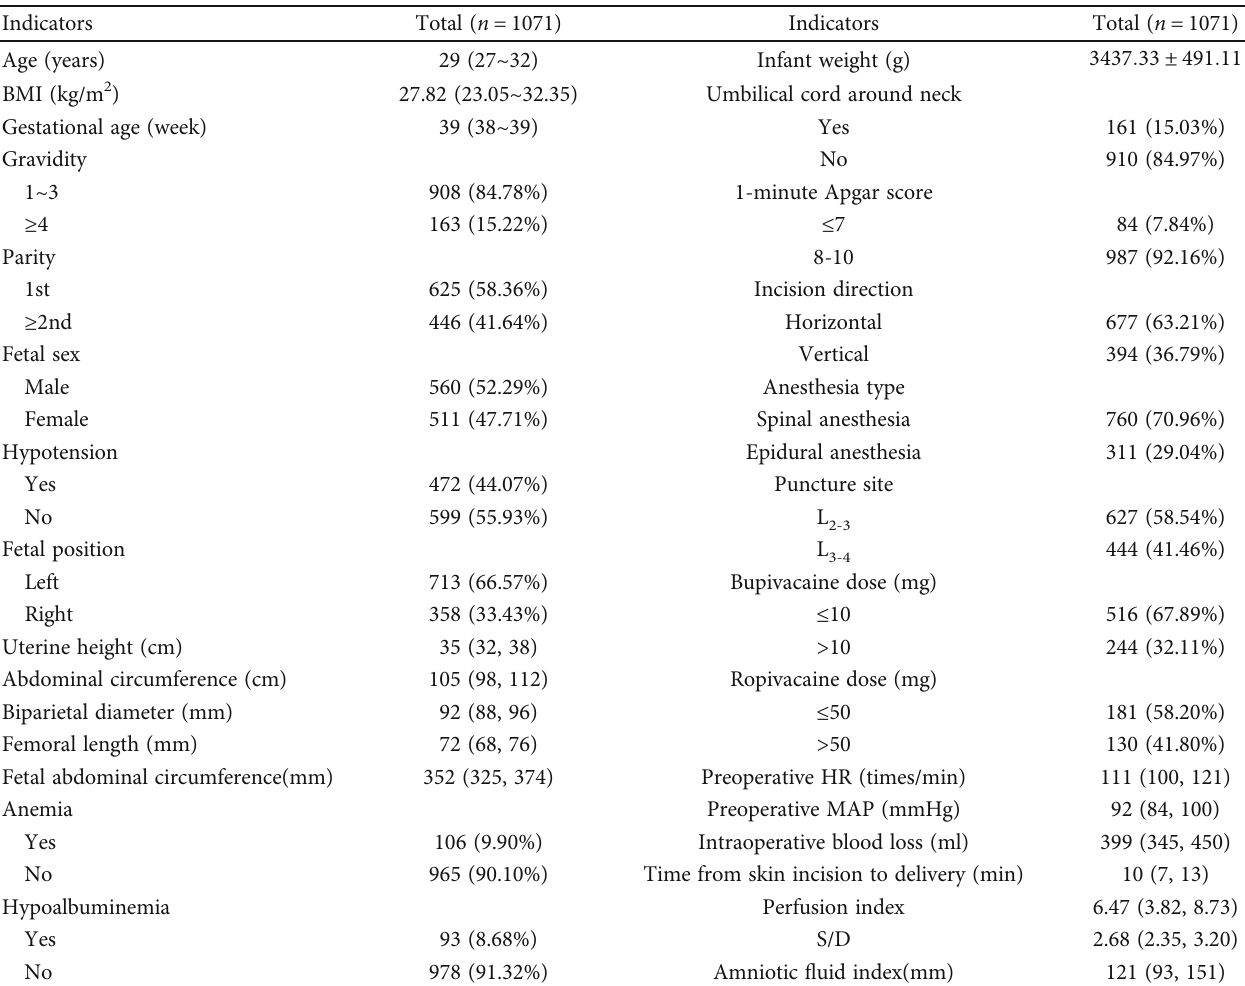
Table 1: Clinical